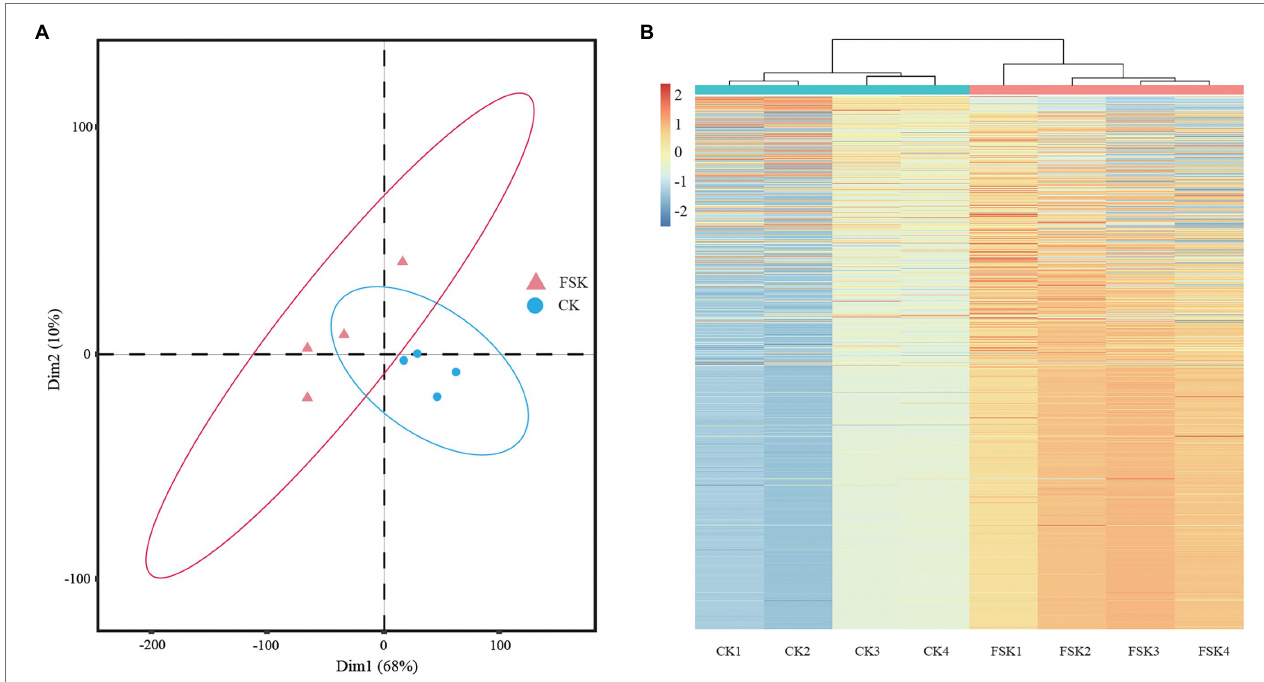
FIGURE 1 | Quality control of samples of different groups. (A) Principal component analysis of samples. (B) Hierarchical cluster analysis of